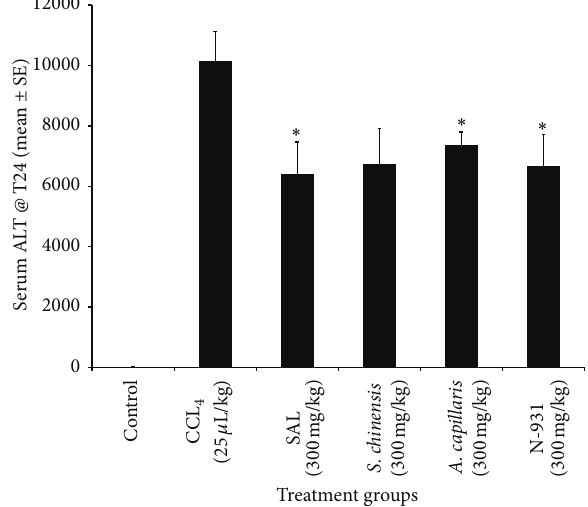
Figure 1: Liver protection activity of the composition of SAL against its individual components at a Dose of 300 mg/kg in APAP-induced hepatotoxicity model. ∗ 𝑝 ≤ 0.05 .